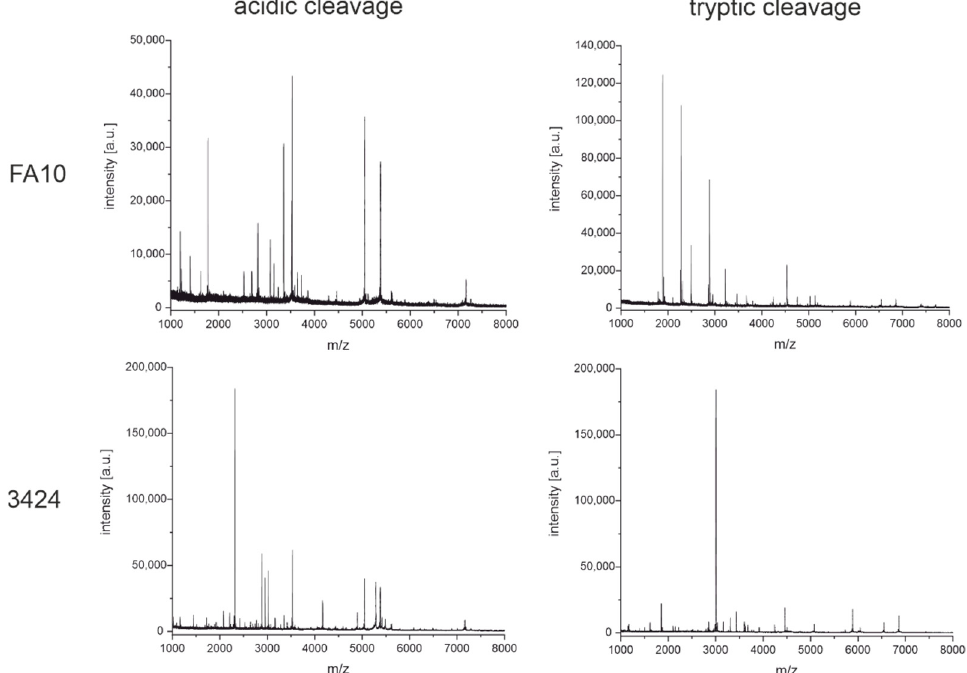
Figure 8. MALDI-TOF fingerprint spectra of the monoclonal antibodies FA10 and 3424 were obtained from cleavage with diluted sulfuric acid for 30 min at 99 °C and tryptic digestion for 15 min at 55 °C. Antibodies FA10 and 3424 originated from different immunizations and have different light chain and intact masses.